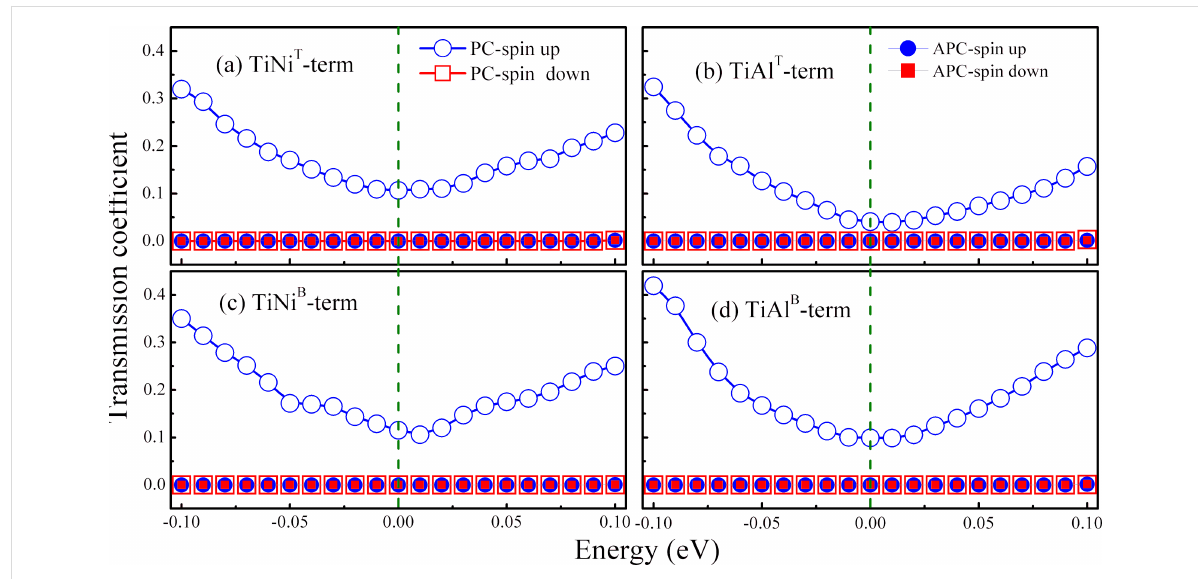
Figure 4: Transmission coefficient versus electron energy in the parallel magnetization configuration (PC) and antiparallel magnetization configura- tion (APC) of the Ti 2 NiAl/Ag/Ti 2 NiAl device with different atomic terminated interfaces. The dashed line is the Fermi level. (a) TiNi T -terminated struc- ture, (b) TiAl T -terminated structure, (c) TiNi B -terminated structure and (d) TiAl B -terminated